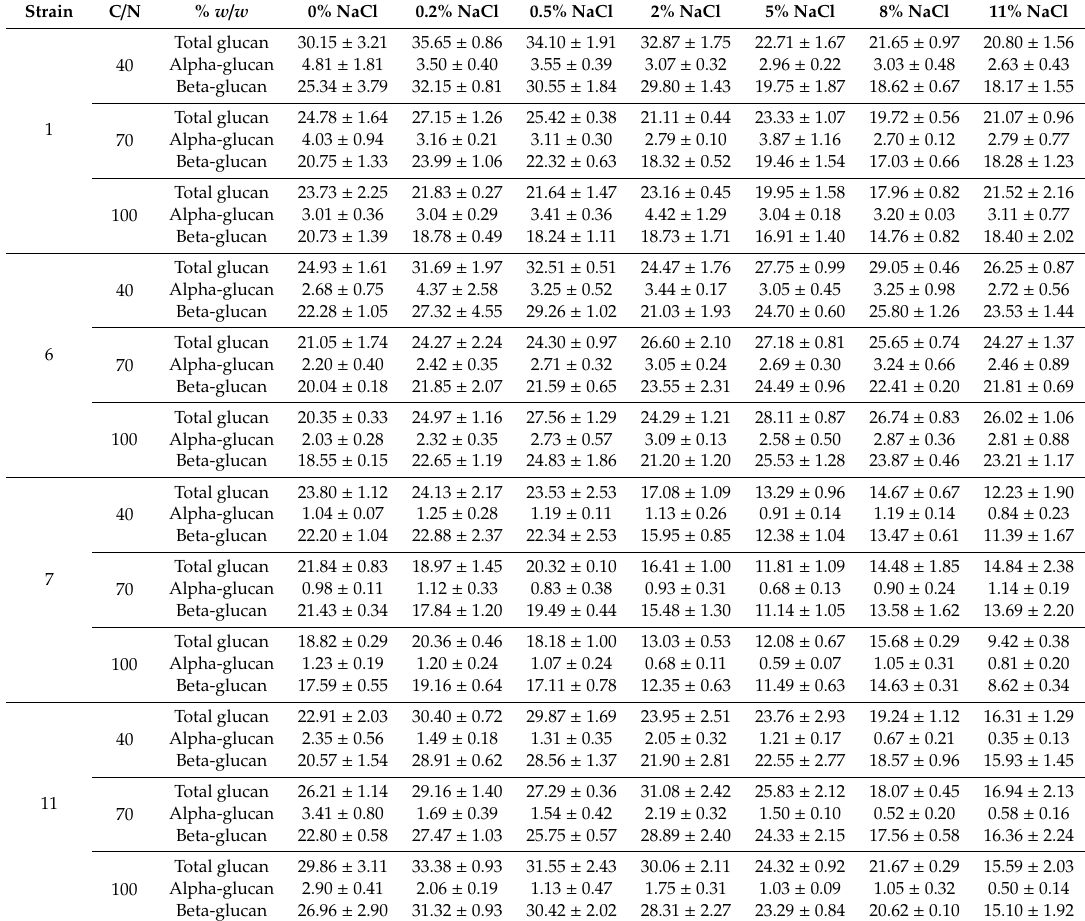
Table 6. The e ff ect of di ff erent osmolarity levels on glucan production in strains C. infirmominiatum CCY